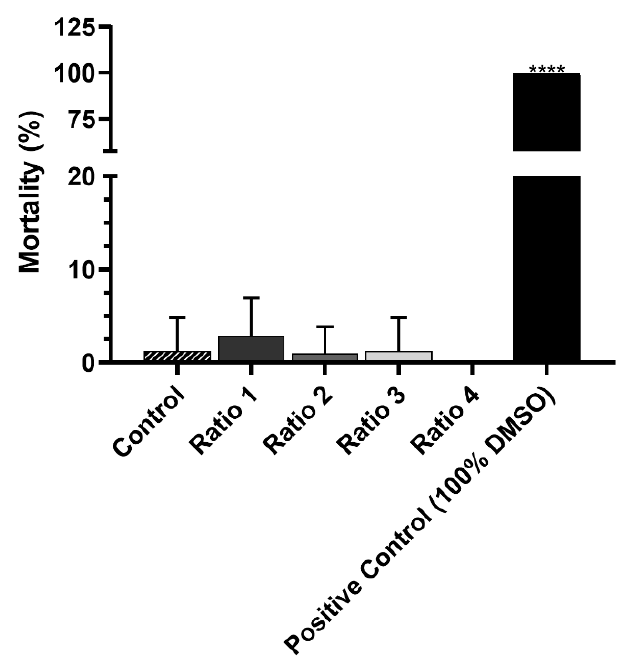
Figure 14. Mortality (%) of Artemia salina incubated for 24 h with only artemia salt medium (Control), with different types of AuNPs (Ratio 1, Ratio 2, Ratio 3 and Ratio 4 AuNPs) at Au concentration of 128 ± 21 µM, and with 100% of DMSO as positive control of mortality (%). The results represent the mean value ± SD, n = 8. Statistical significance represents: **** p < 0.0001 compared with the group incubated only with artemia salt